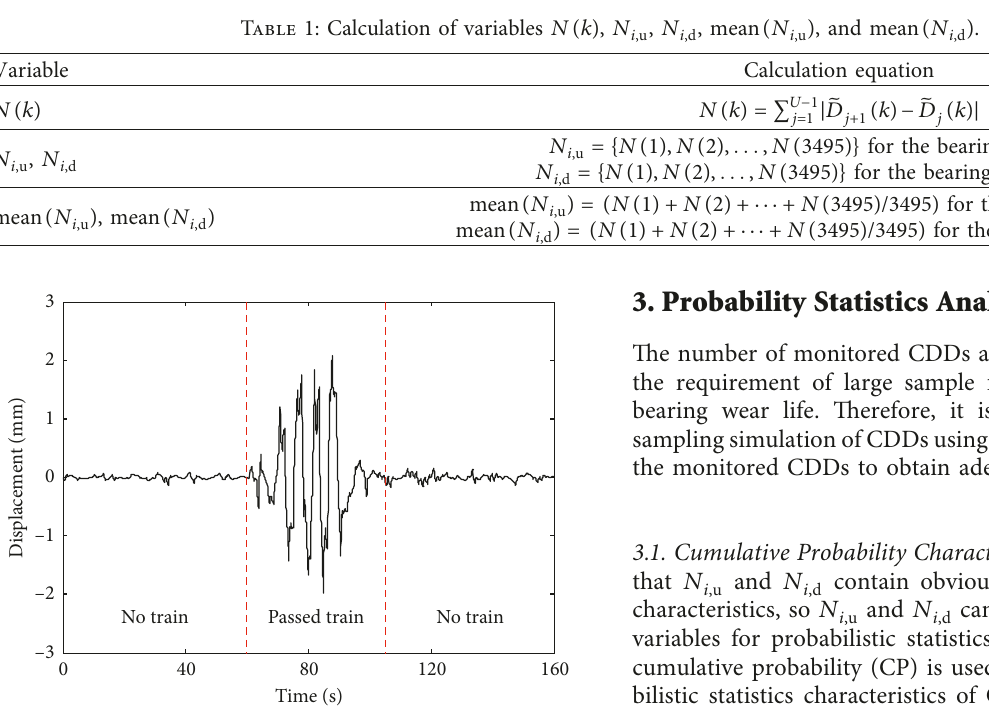
caused by one 3 , u